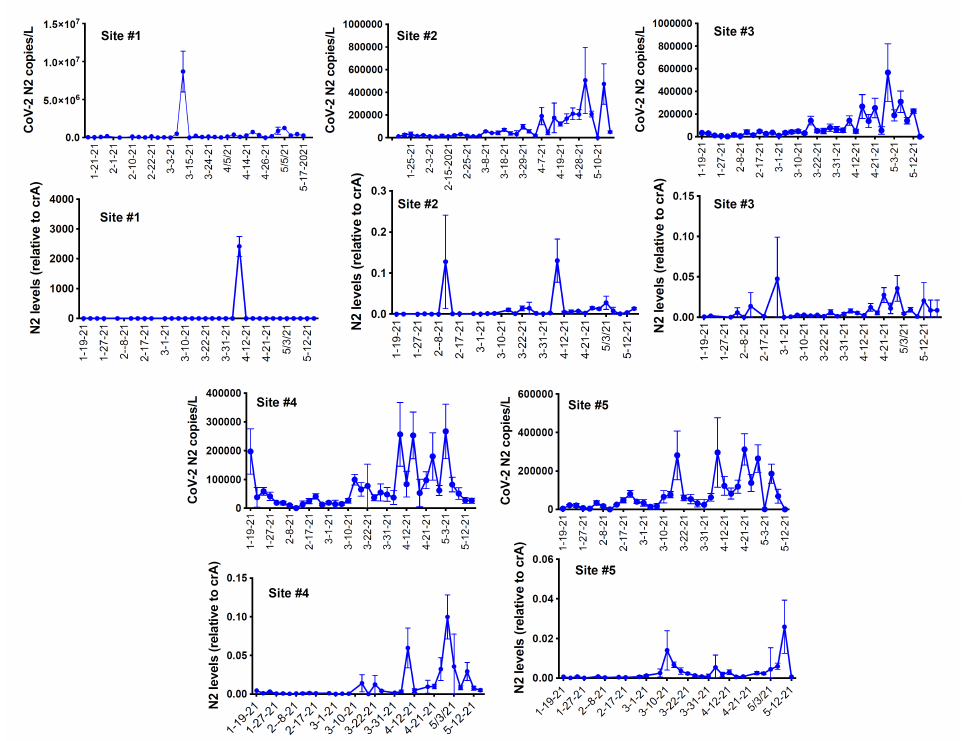
Figure 4. The analyses of the SARS-CoV-2 gene copies in the samples collected from the UToledo campus sites in the UTCWMN program. The SARS-CoV-2 viral N mRNA levels (copies/L), relative to crAssphage, were analyzed by